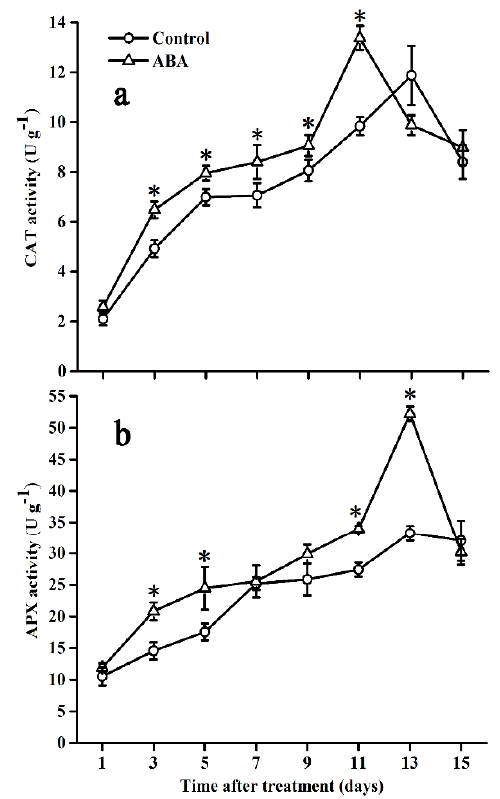
Figure 6. Effect of ABA on CAT ( a ) and APX ( b ) activities in the tomato during storage at 20 °C. Vertical bars represent the standard deviation (SD, n = 3). Asterisks (*) represent significant differences ( p < 0.05) between the ABA and control treatments.